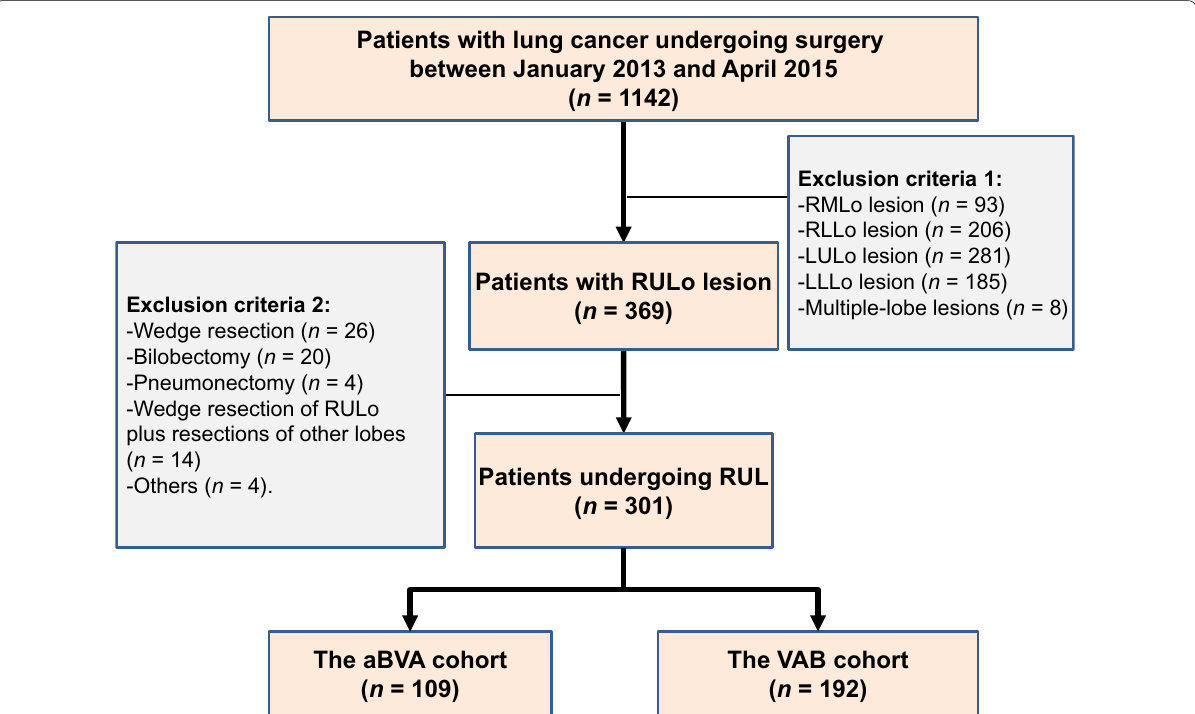
Fig. 2 The study flow chart to screen eligible patients undergoing RUL with two different surgical approaches. RULo right upper lobe; RUL right upper lobectomy; RMLo right middle lobe; RLLo right lower lobe; LULo left upper lobe; LLLo left lower lobe; aBVA RUL with the dissecting order of the posterior ascending arterial branch [a], followed by the right upper bronchus [B] and pulmonary vessels [VA]; VAB RUL with the dissecting order of the right upper pulmonary veins and arteries [VA], followed by the right upper bronchus